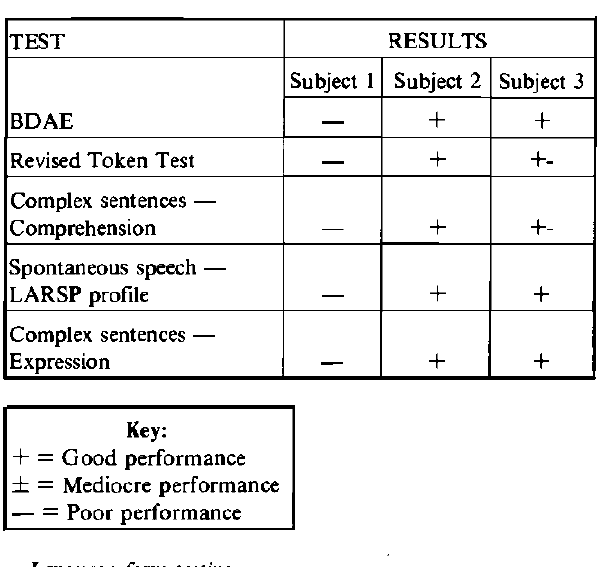
Table 3: Results of subjects' performance on receptive and expressive language